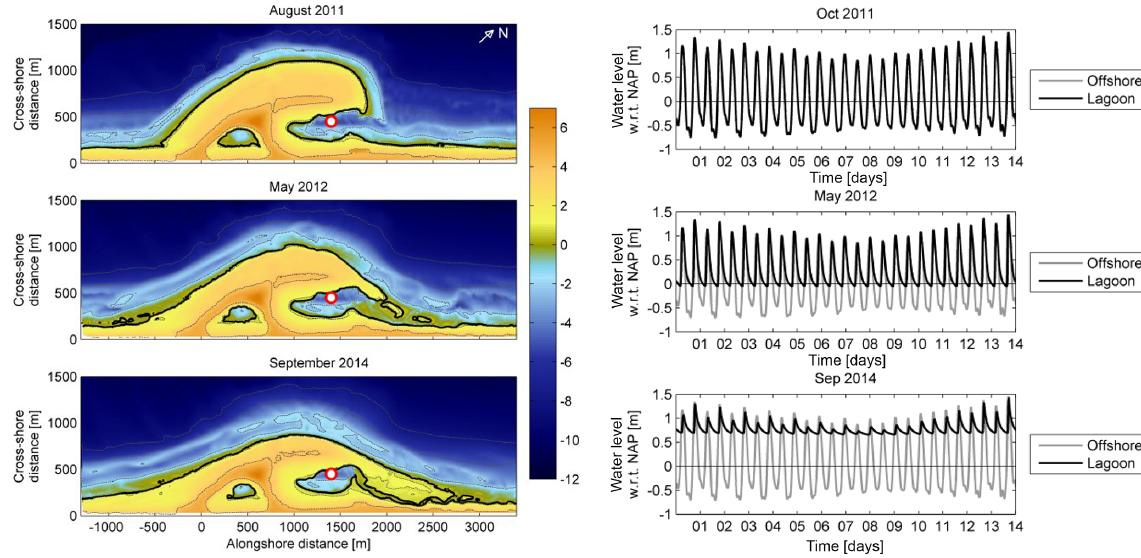
Figure 3. The images show three measurements of distinct morphologies of the Sand Engine domain in 2011, 2012, and 2014. The red circle represents the location where tides inside the lagoon are calculated with the Delft3D flow model in de Vries et al. (2015). The graphs show the simulated tides inside and outside the lagoon as obtained with the three successive